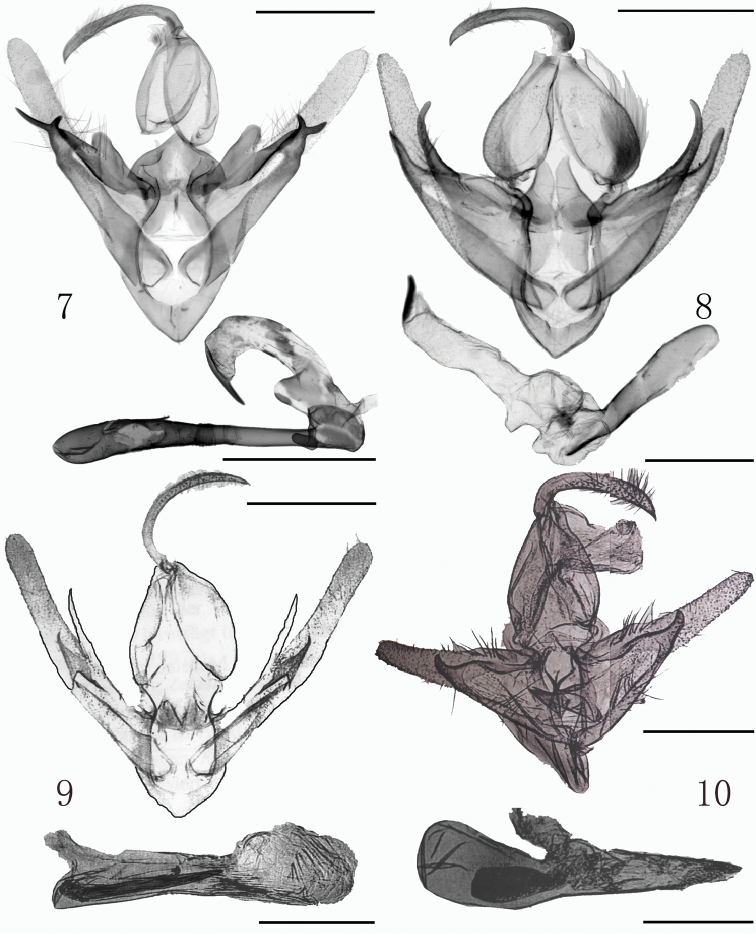
Rhynchina spp., male genitalia 7R.taibaishana sp. n., holotype 8R.deqinensis Han, 2008, holotype 9R.helga Gaal, 1998 (after Mayerl and Lödl 1999) 10R.mandarinalis Leech, 1900 (after Mayerl and Lödl 1999). Scale bar: 1 mm.